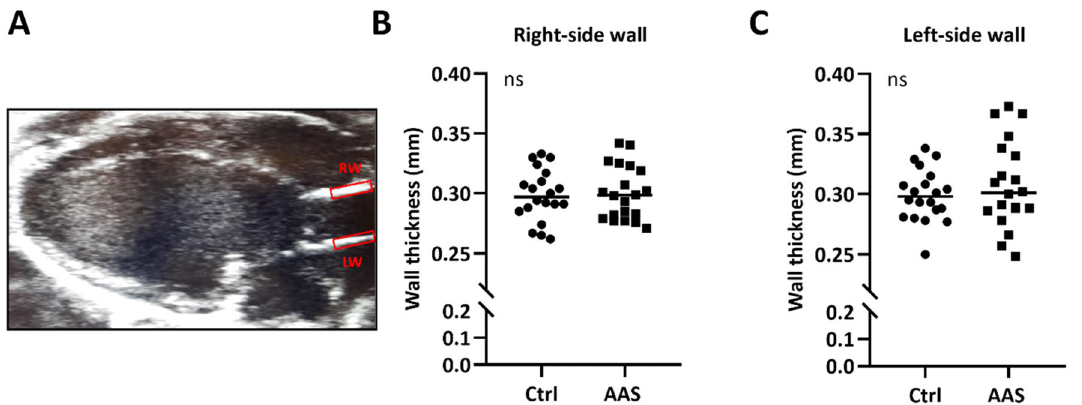
Figure 5. Vascular morphology: ( A ) B-mode image of a mouse heart acquired from 2D echocardiography showing the left ventricle in a parasternal long axis view, apex pointing to the left and aorta to the right. The boxes illustrates the areas of the ascending aorta used for measurements of wall thickness. RW right-side wall, LW left-side wall. ( B , C ) Wall thickness measured on the RW and LW of the ascending aorta after 14 days of testosterone exposure. Testosterone treated animals = AAS (N = 20), sham operated animals = Ctrl (N = 20). Data presented with